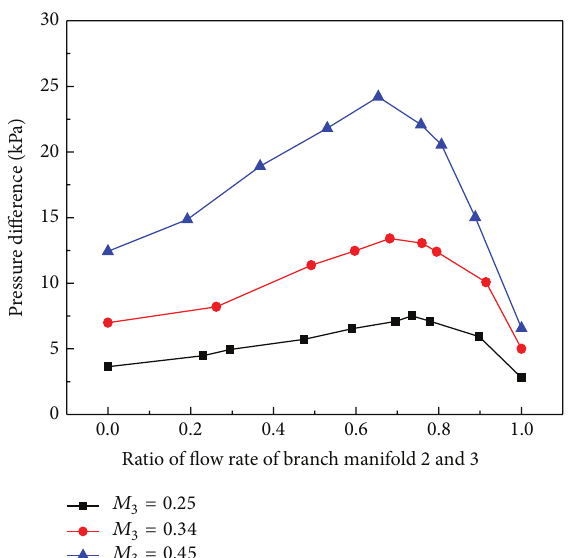
Figure 9: Pressure difference from branch manifold 2 to branch manifold 3.